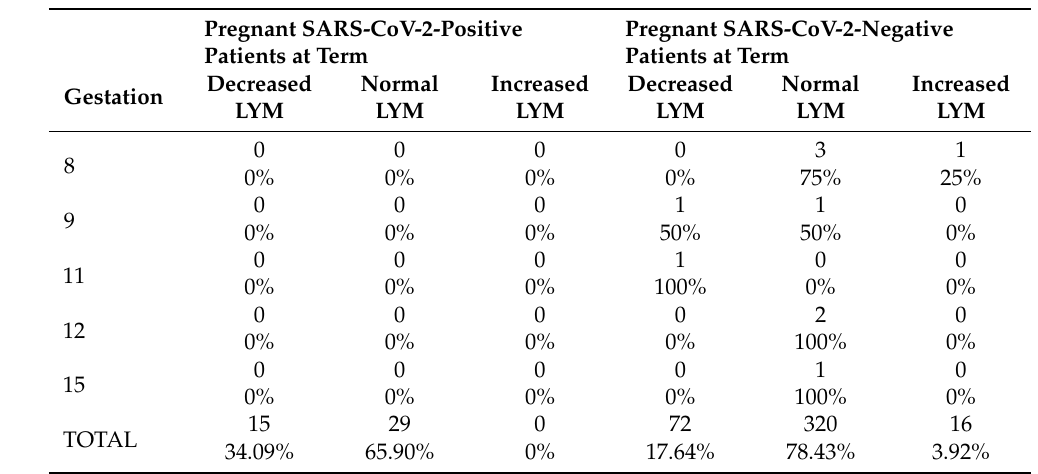
Pregnant SARS-CoV-2-Negative Patients at Term